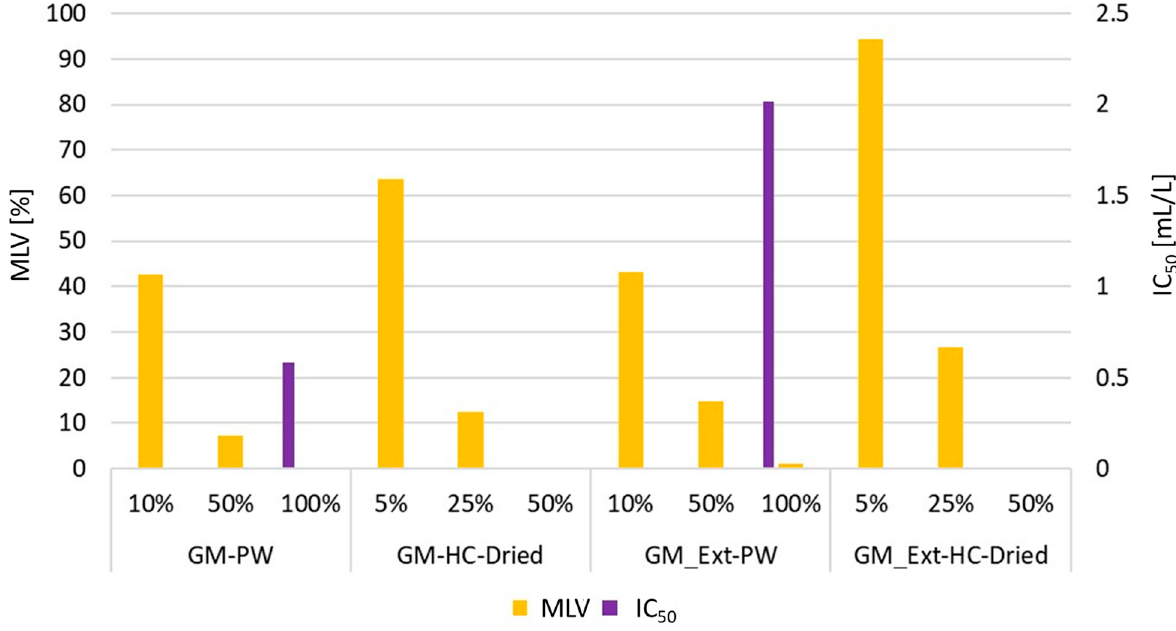
Figure 8. Comparison between MLV (Munoo-Liisa Vitality index) for hydrochar and process water for GM and GM_Ext and the IC 50 (inhibition dose) for process for GM and GM_Ext and the IC 50 (inhibition dose) for process water.